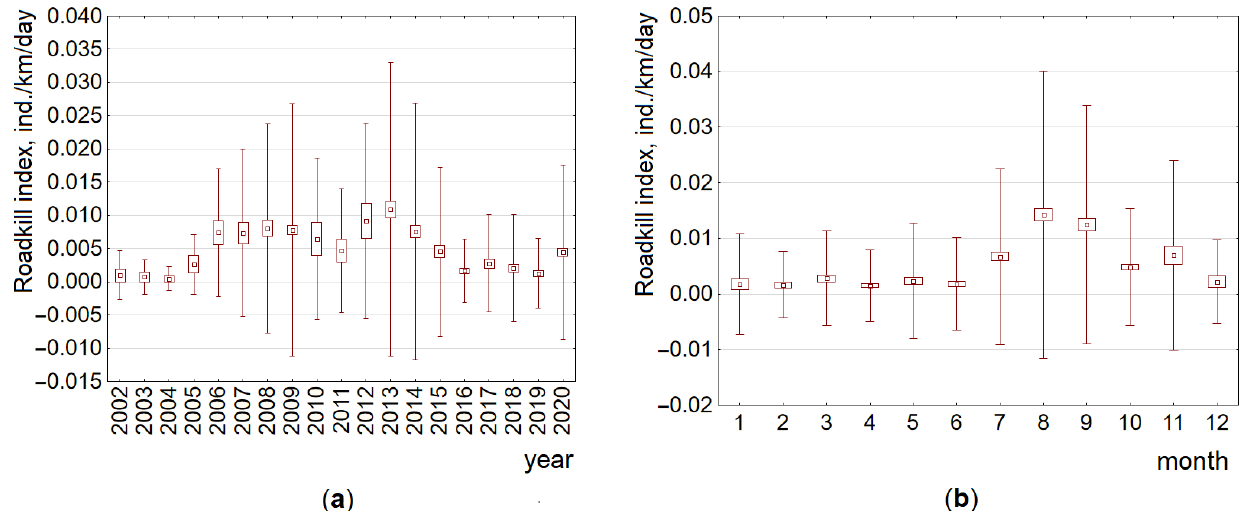
Figure 3. Raccoon dog roadkill trends by year ( a ) and by month ( b ) at the country scale, 2002–2020. Data from the Lithuanian Police Traffic Supervision Service in 2002–2020 and the Nature Research Centre in 2007–2020 are pooled and presented as averages, SE (box) and SD